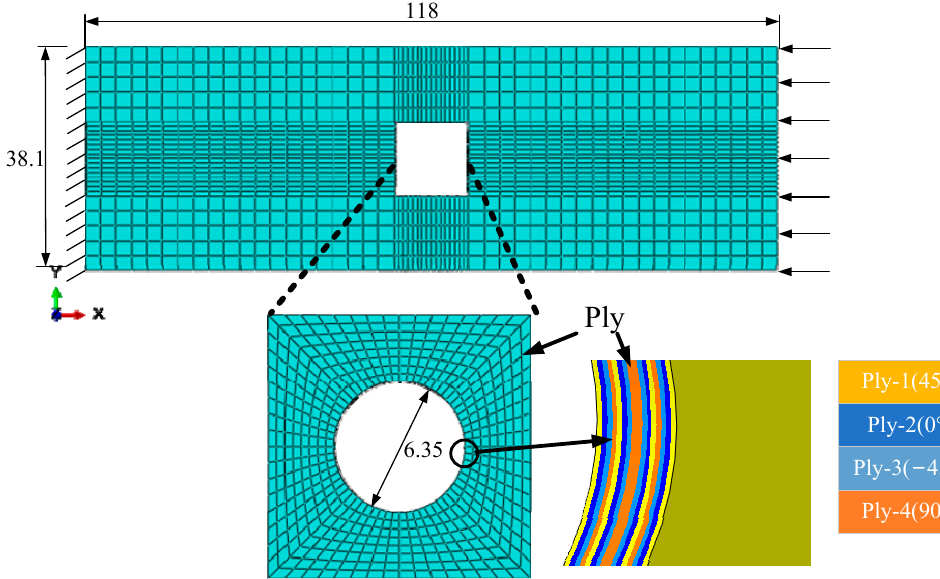
Figure 1. Finite element discretization for the macroscale model.